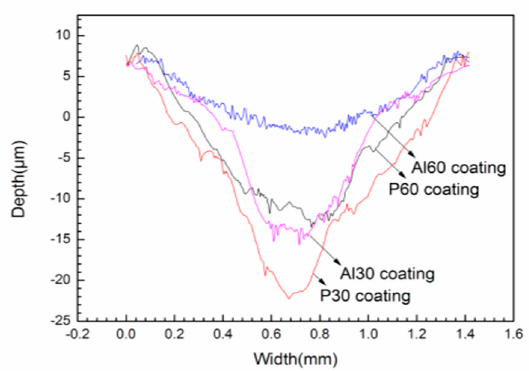
Figure 9. Cross-sectional profiles of wear marks at loads 5 N under dry friction conditions on the PEO coatings. Table 1. The average friction coefficients and wear rates of the PEO coatings.